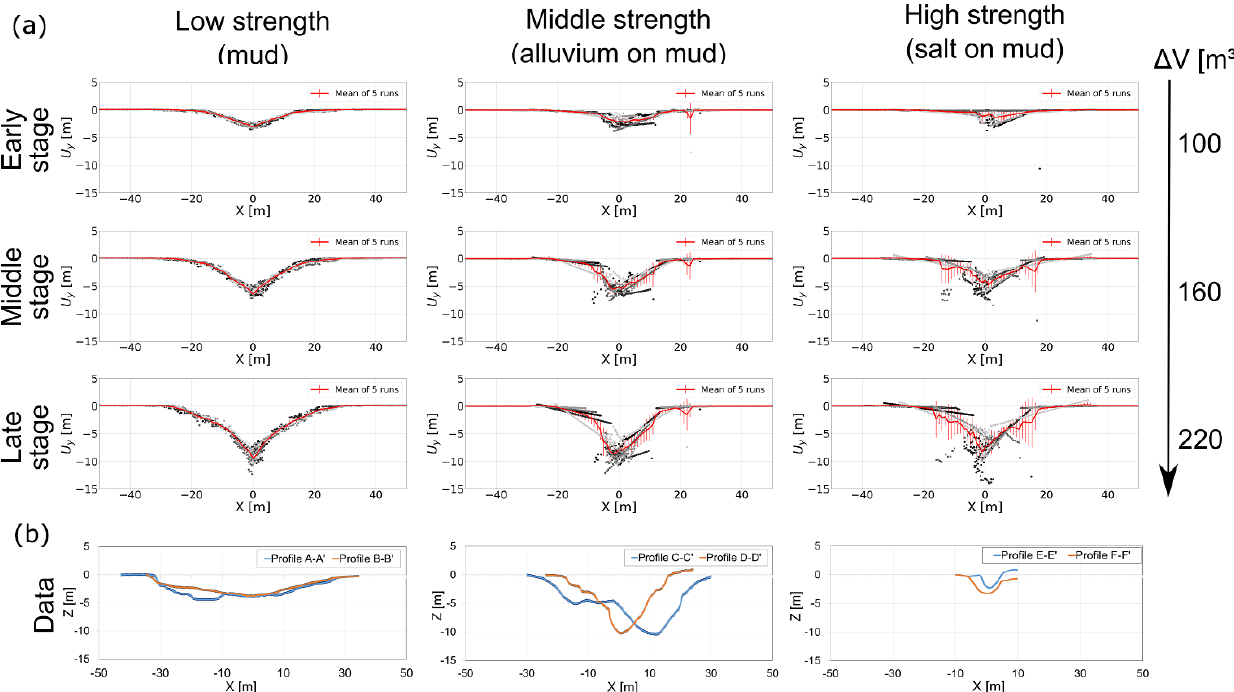
Figure 14. Topographic cross-sections of sinkholes in different cover materials. (a) Modelled profiles for subrosion zones in 30m depth and three different evolution stages. Plotted is the vertical position of the surface particles for five different particle assemblies of each tested model setup. Model sets are pure lacustrine mud (left row), alluvium on mud multilayer (middle row) and salt on mud multilayer (right row). (b) Field data replotted topographic profiles of the three different sinkhole morphologies from Fig. 3. The distance and altitude are normalised for better comparison with the models.